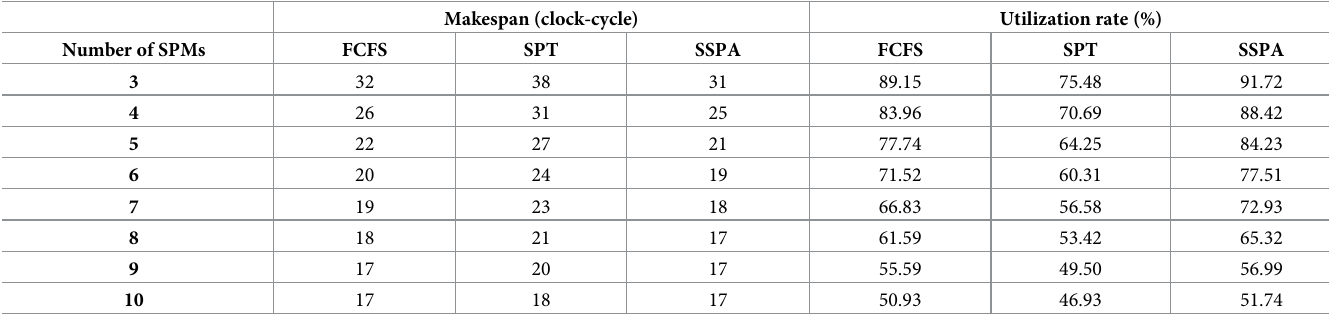
Table 6. Results for variable number of